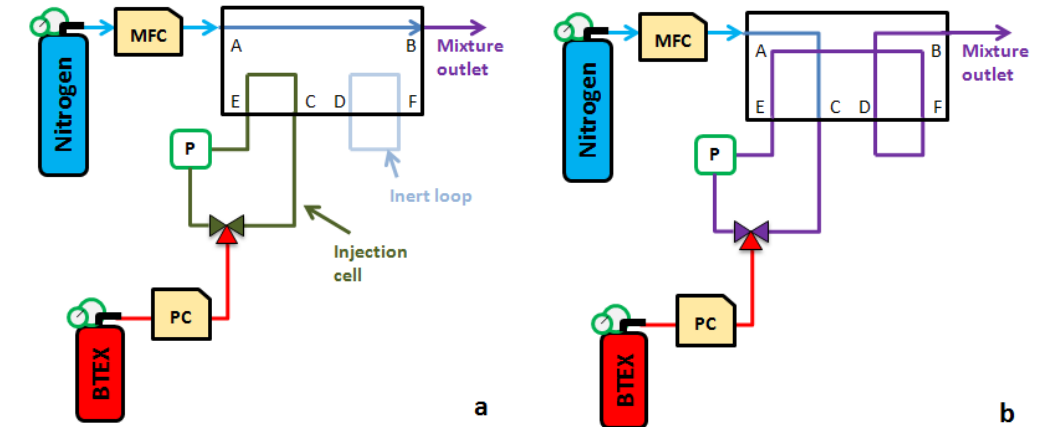
Figure 1. Schematic diagram of the gas pulse generator with a 6-way 2 position solenoid valve allowing it to generate a pure nitrogen gas train ( a ) and a nitrogen train loaded with a gas pollutant ( b ).